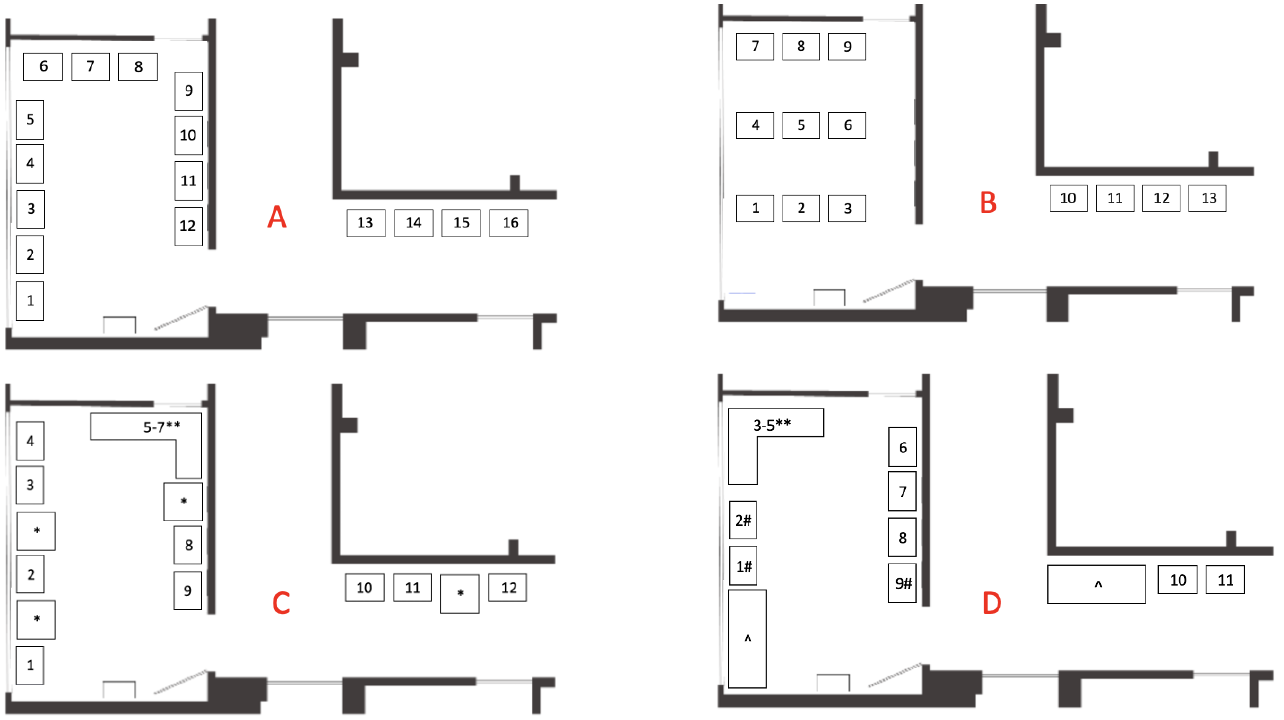
Figure 5. Potential re-organized floorplans. The numbers refer to chairs. ( A ) Current floorplan. ( B